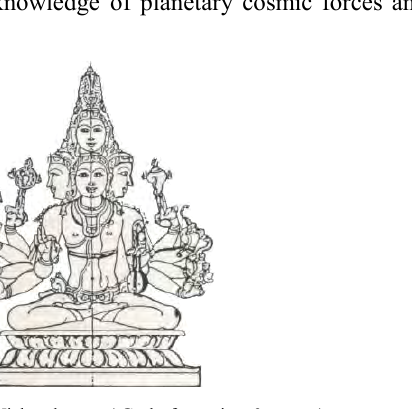
Figure 1 Lord Vishwakarma ( God of creation & vastu )